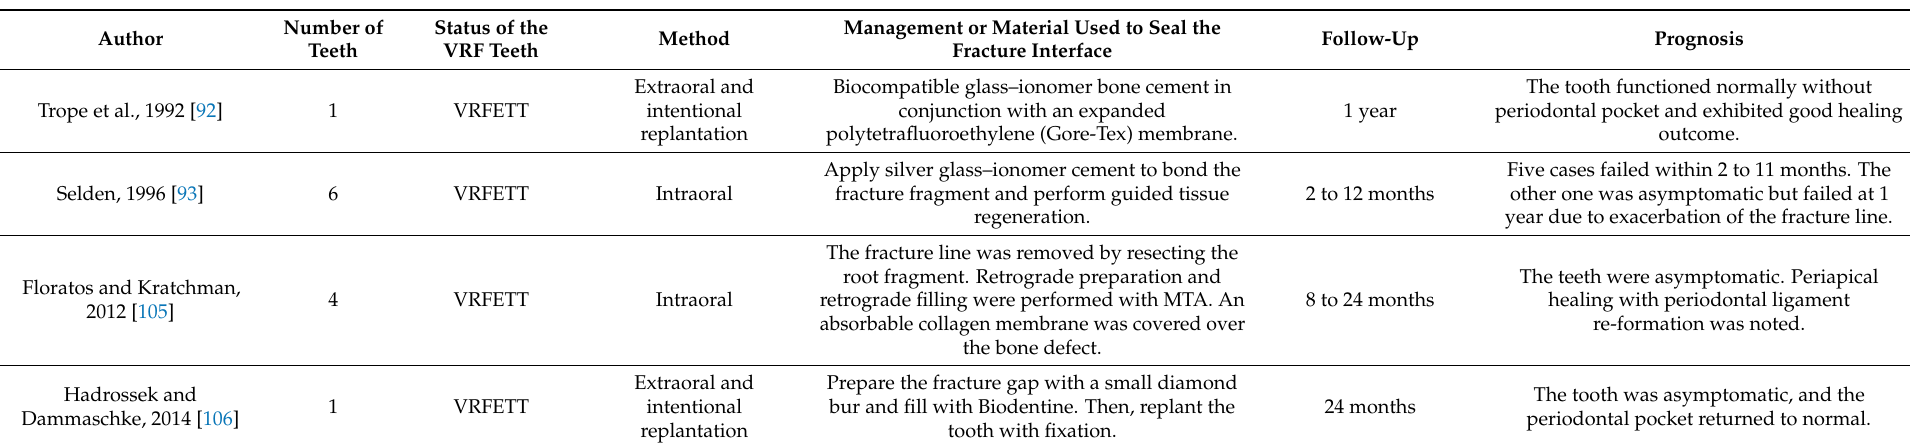
Table 6. Research regarding the re-cementation of VRFs with glass-ionomer materials or sealing with bioceramic